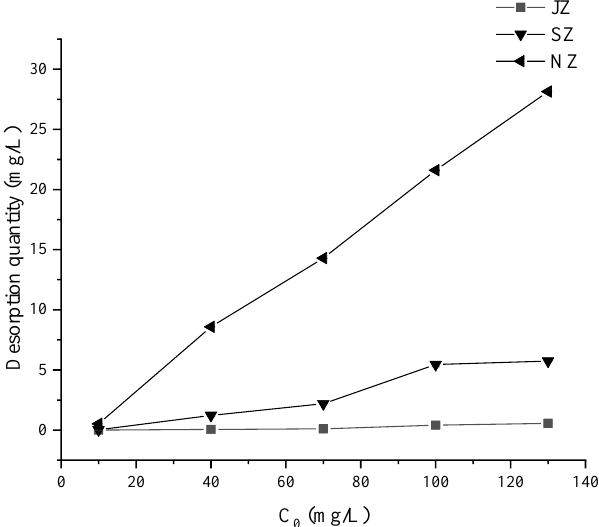
Figure 10. Curve presenting desorption of Cd by modified and natural zeolite. Table 4. Desorption rates of Cd by modified and natural zeolite.